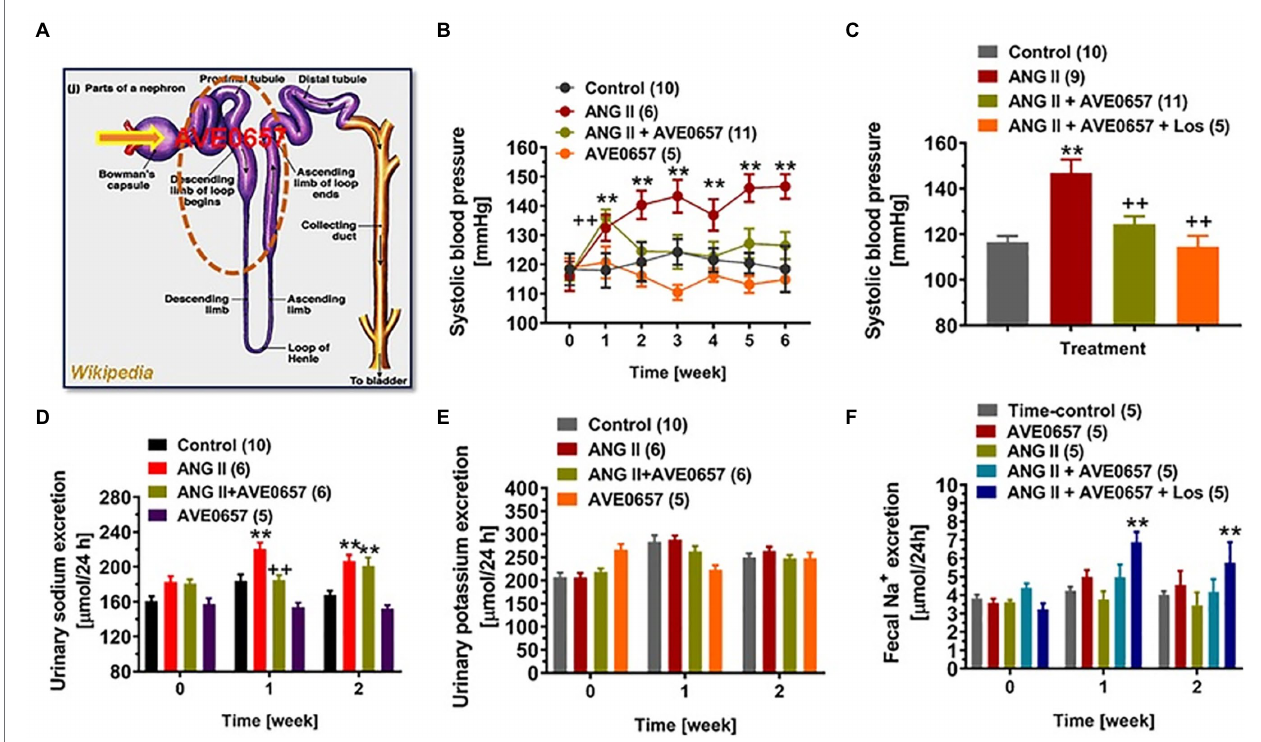
FIGURE 6 | An orally absorbable NHE3 inhibitor AVE0657 (20 mg/kg/day, p.o., Sanofi-Aventis) significantly attenuated ANG II-induced hypertension in male C57BL/6 J mice infused with a slow pressor dose of ANG II at 0.5 mg/kg/day, i.p., for 2 weeks. Upon oral ingestion, AVE0657 is absorbable from the gut into the circulation, which is filtered by the glomerulus into the proximal tubules to inhibit NHE3 in the apical membranes (A) . (B) AVE0657 attenuated the development of Ang II-induced hypertension. (C) Concurrent treatments with AVE0657 and Ang II receptor blocker losartan completely blocked the development of Ang II-induced hypertension. (D) The effect of AVE0657 on natriuretic response. (E) AVE0657 had no effect on urinary potassium excretion. (F) AVE0657 had no effect on fecal sodium excretion. ** p < 0.01 vs. time-control group; ++ p < 0.01 vs. ANG II group. Reproduced from Li et al. (2019b) with permission from the copyright